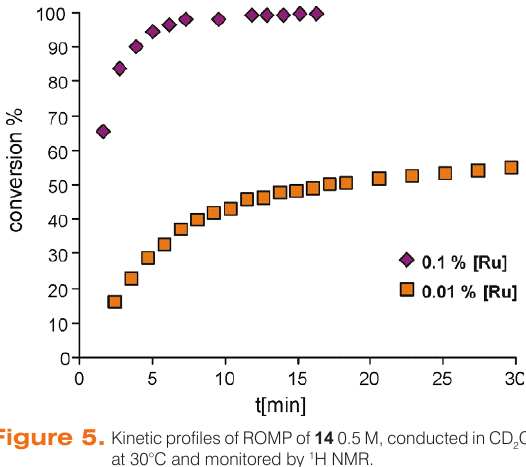
Figure 5. Kinetic profiles of ROMP of 14 0.5 M, conducted in CD at 30°C and monitored by 1 H NMR. Table 1. ROMP and CM conducted in the presence of 3